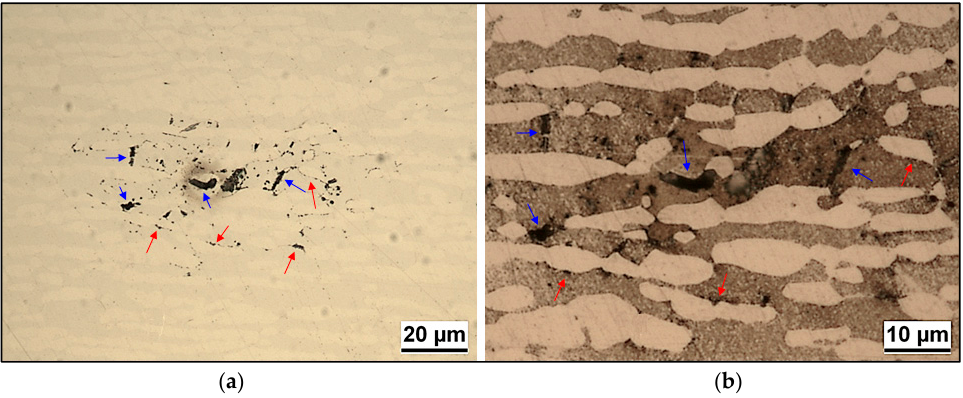
Figure 6 . Micrograph of LDSS 2404 electrode aged for 10 min at 750 °C, after CPT test in 0.1 M NaCl solution before ( a ) and after etching ( b ) with Beraha’s reagent.